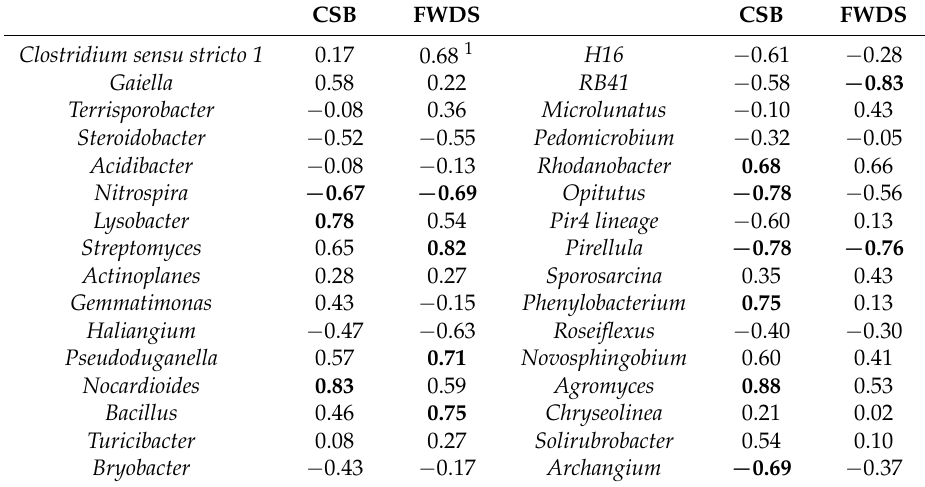
− 0.43 − 0.17 Archangium − 0.69 − 0.37 1 Values in bold are significant ( p <